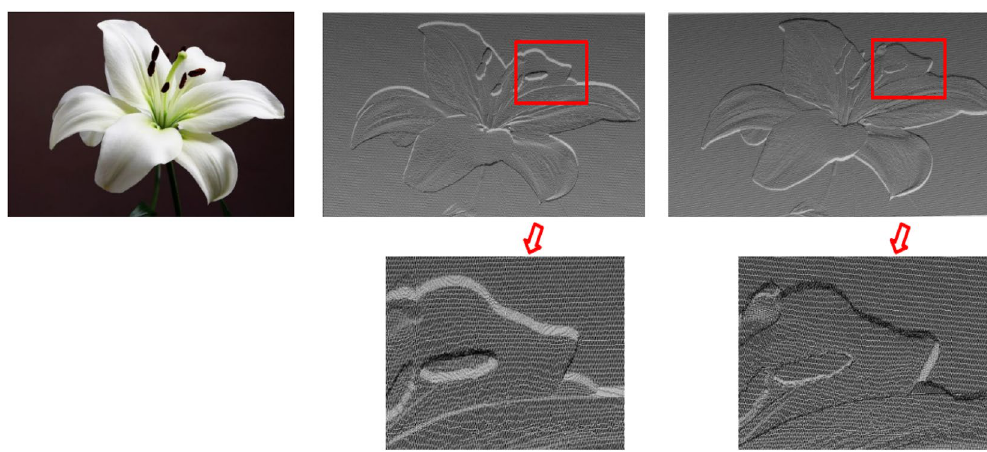
Figure 12. Point cloud comparison images of the “lily